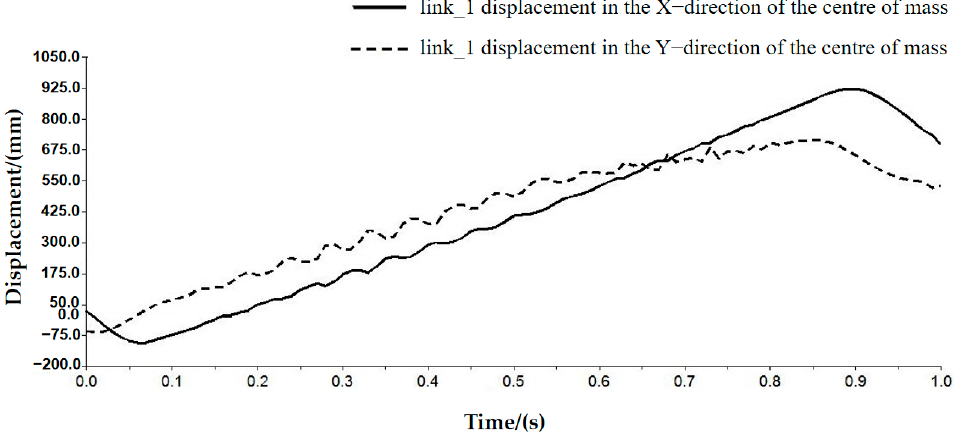
Figure 10. Graph of displacement of link_1.